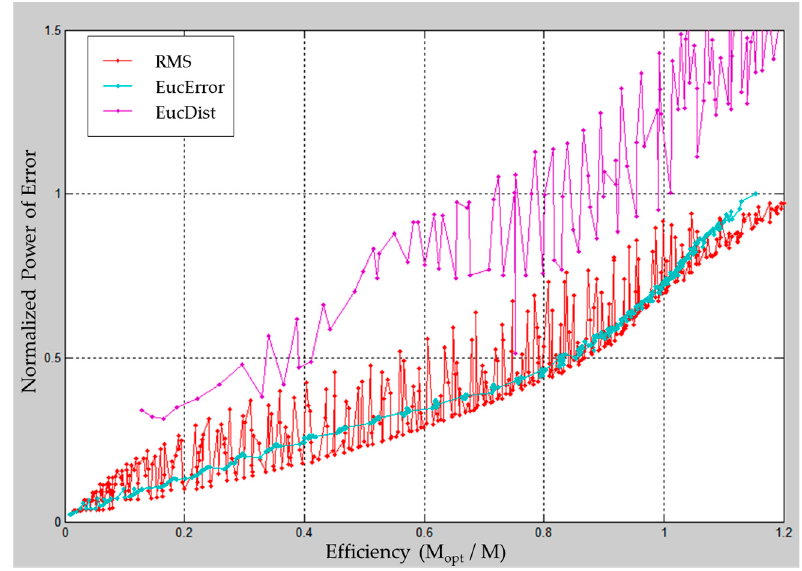
Figure 7. Performance variations according to types of error function.